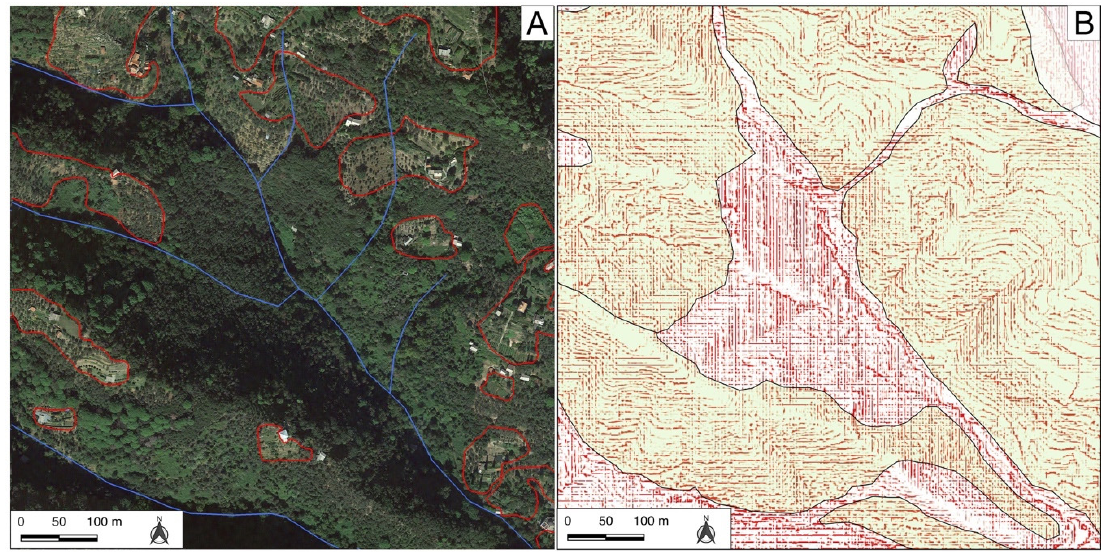
Figure 5. A detail of the studied catchments, the dotted box of Figure 2. ( A ) terrace identification on orthophotography. ( B ) in light green terrace identification with LUC method.